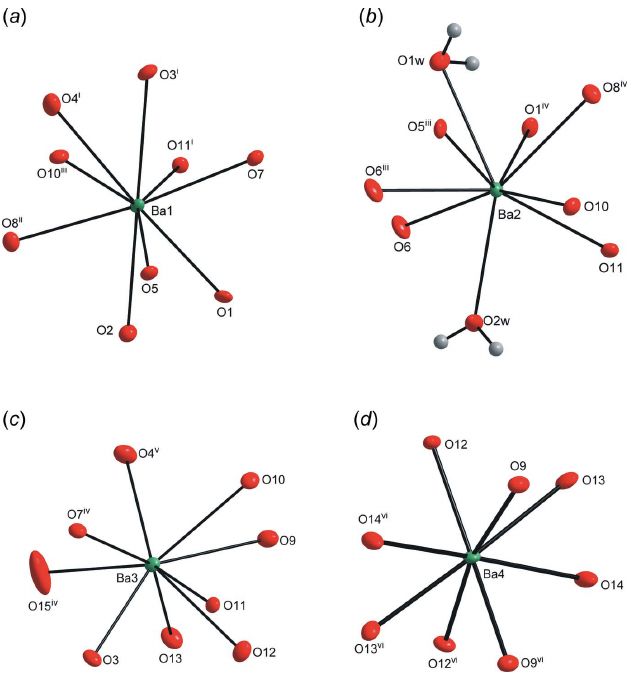
Figure 3 Molecular structures of the propionate molecules, with displacement Figure 2 ellipsoids shown at the 50% probability level. ( a ) molecules with the Aview of the oxygen coordination around the cations, with displacement carboxylate atom C1, ( b ) molecules with the carboxylate atom C4, ( c ) ellipsoids shown at the 50% probability level. ( a ) Ba1 2+ , ( b ) Ba2 2+ , ( c ) molecules with the carboxylate atom C7, ( d ) molecules with the Ba3 2+ and ( d ) Ba4 2+ [Symmetry codes: (i) x (cid:4) 1 , (cid:4) y + 1 , (cid:4) z + 1; (ii) (cid:4) x + 1 , carboxylate atom C10, ( e ) molecules with the carboxylate atom C13, ( f ) 2 2 2 y + 1 , z ; (iii) (cid:4) x + 1, (cid:4) y + 1, (cid:4) z + 1; (iv) x + 1 , (cid:4) y + 1 , (cid:4) z + 1; (v) x + 3 , y + 1 , molecules with the carboxylate atom C16 and ( g ) molecules with the 2 2 2 2 2 z ; (vi) (cid:4) x + 1, y , (cid:4) z + 3 ]. carboxylate atom C19. 2